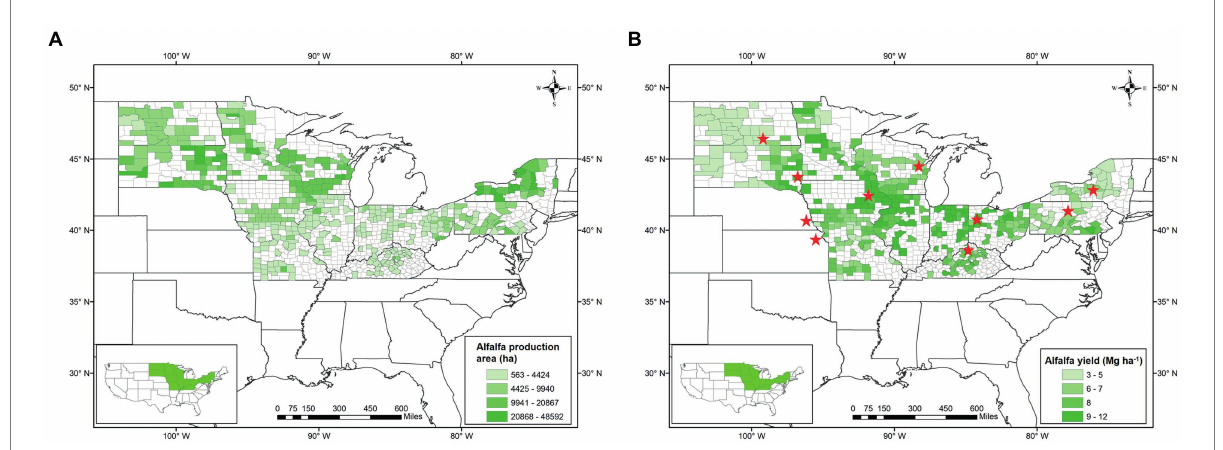
FIGURE 1 Map of the US showing selected rainfed alfalfa producing counties ( n = 393) in green for harvested area (A) and forage yield (B). The red stars in panel B represent the locations ( n = 10) from where alfalfa yield data obtained from research experiments were used for this study. Inset shows selected states as rainfed states within the continental US for this study.